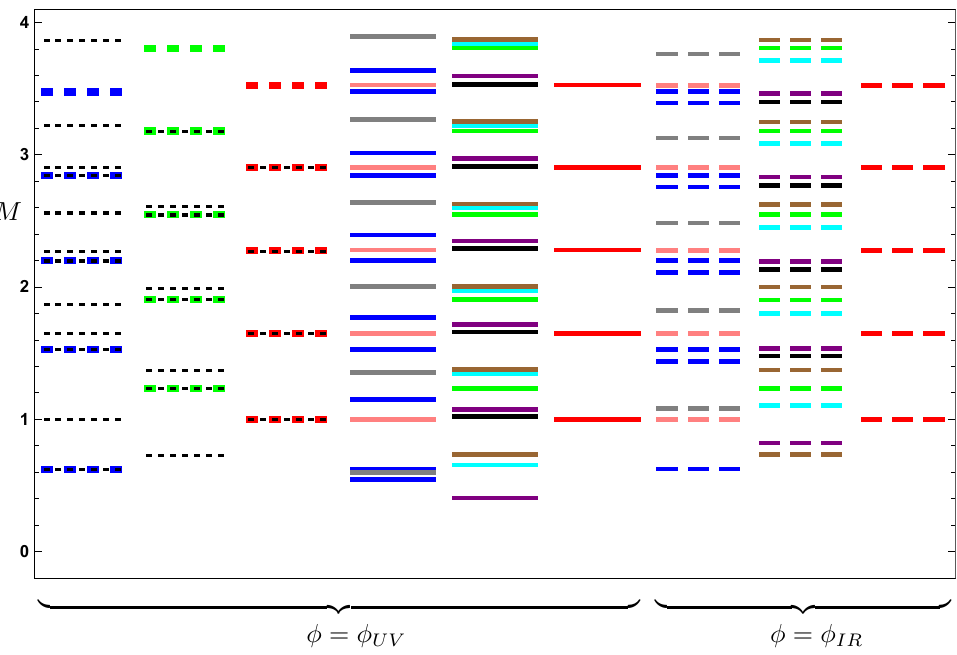
Figure 4 . Masses of two scalars associated with (cid:31) and (cid:30) (blue), scalar adjoint of SU(2) (cid:25) i (pink), U(1) scalar X obtained as gauge-invariant combination of A 6 and B 65 (grey), gravi-photon V (cid:22) (green), vectorial adjoint of SU(2) A i (brown), U(1) vectorial B 6 (cid:22) (purple), U(1) vector X (cid:22) gauge- (cid:22) invariant combination of B 5 (cid:22) and A (cid:22) (black), U(1) 2-form B (cid:22)(cid:23) (cyan), and tensorial (red) (cid:13)uctua- tions, for the model obtained from the circle compacti(cid:12)cation of the D = 6 supergravity theory, as computed in [64] (short dashed), by the authors of [65] (dotted, black) and by us (continuous and long dashed). In our calculation, we retain one extra scalar mode compared to [64], corresponding to (cid:13)uctuations of (cid:30) , the spectrum of which depends on the value of (cid:30) 0 . The three towers in the middle (continuous) of the (cid:12)gure are the spectrum obtained for (cid:30) = (cid:30) UV = 0 (see also table 1), 1 while the three rightmost towers (long-dashed) are the spectrum for (cid:30) = (cid:30) IR = log(3) (see also 4 (cid:0) table 2). In the calculations, we (cid:12)xed (cid:26) 1 = 0 : 001 and (cid:26) 2 = 8. Notice that the spectrum from [65] contains six towers: three of them agree with [64] as well as us, one agrees with the vector SU(2) (cid:12)elds from our calculation, one scalar is degenerate with the tensor, and agrees with our SU(2) adjoint scalars (cid:25) i , up to small numerical